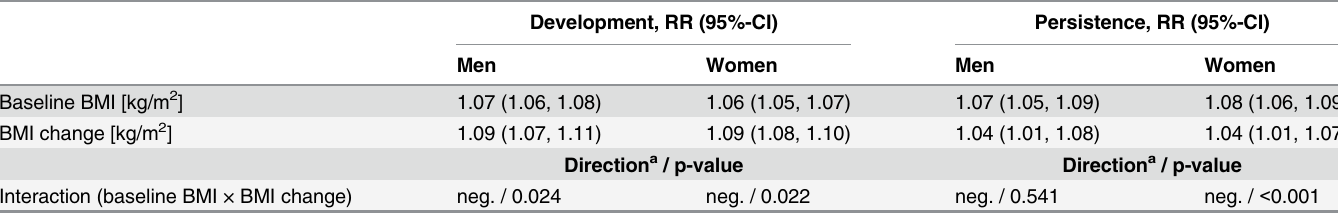
Table 4. Age adjusted linear associations of baseline BMI and BMI Change on relative risk for development and persistence of